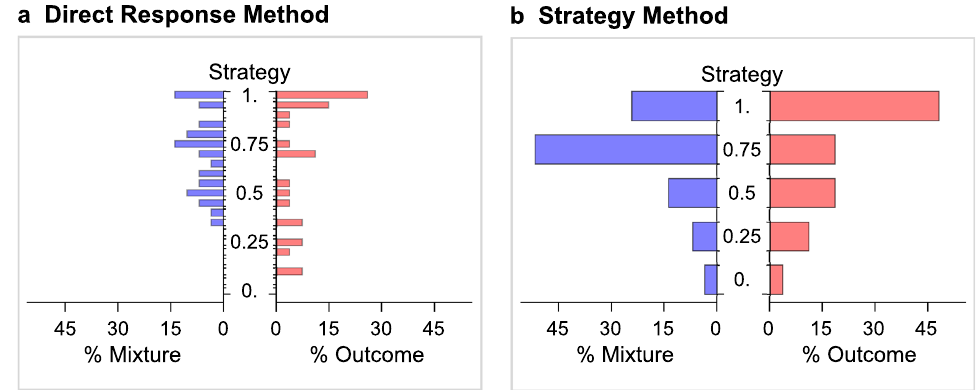
Figure 3. Distribution of Players’ 2 strategies. The histogram bars represent the frequency with which each strategy is played within the population of Players 2. In the DRM, a strategy is the fraction of periods in which Player 2 plays C, while in the SM a strategy is the one submitted by Player 2. In the Outcome treatments ( n = 27 ), the most frequent strategy is the fully cooperative one, in which C was chosen throughout the repeated game. In the Mixture treatments ( n = 29 ), 0.75 is a modal choice in both the DRM and the SM. This is in accordance with our Prediction